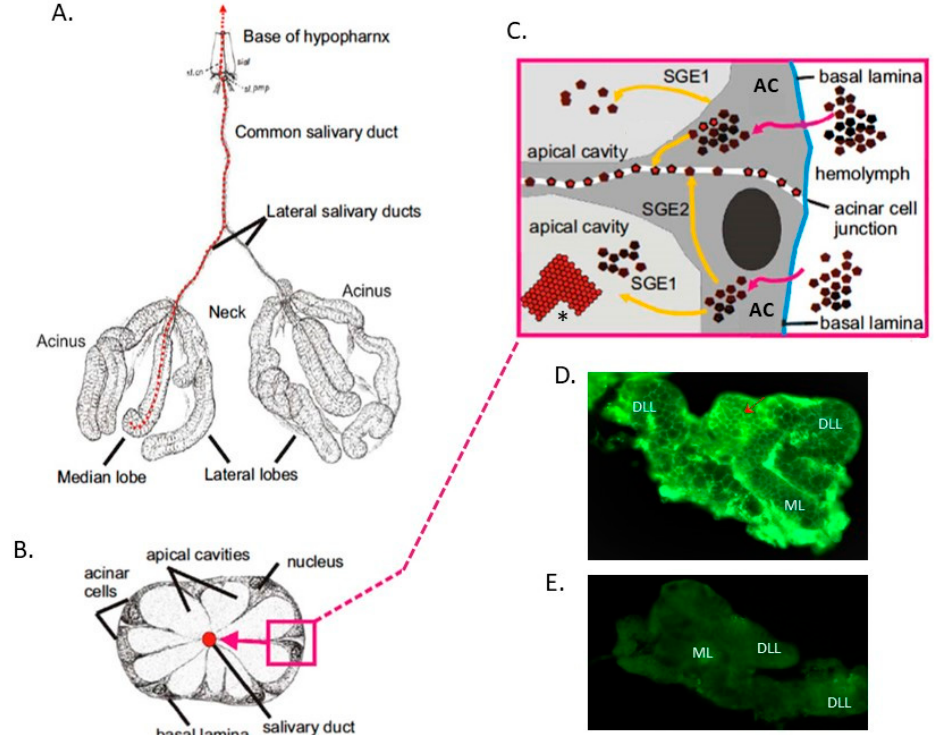
Figure 1. Structure of Aedes spp. salivary glands [3]. ( A ) Schematic representation of salivary glands of a mosquito at 2 days post-emergence. ( B ) Transverse section through a median lobe of the salivary gland showing the acinar cells and their relationship to the salivary duct. ( C ) An enlargement of B showing a cartoon of a transverse-section of salivary gland indicating mature virus penetrating the basal lamina to establish an infection in the acinar cells ( A , C ) and then penetrating the plasma membrane to fill the apical cavity and/or accumulate in the acinar cell junctions. Pink arrows trace arbovirus entry and movement in individual acinar cells leading to the virus’ eventual release through the apical cavity (yellow lines). Salivary gland escape (SGE)1 and SGE2 refer to potential barriers (entry into the apical cavity and acinar cell junctions, respectively) for virus escape from salivary glands ( D ) Immunofluorescence of salivary gland lobe infected with DENV-2 Merida (Cosmopolitan) at 7 dpi shows that mature viral particles clearly accumulated in acinar cell junctions (red arrow). ( E ) Uninfected salivary glands showed no immunofluorescence signal. N: nuclei. SD: salivary duct. AC: apical cavity for saliva storage. BL: basal lamina. Cyt: Cytoplasm. CM: Cell membrane. DLL: distal lateral lobe, ML: medial lobe. * Represents a virus cluster